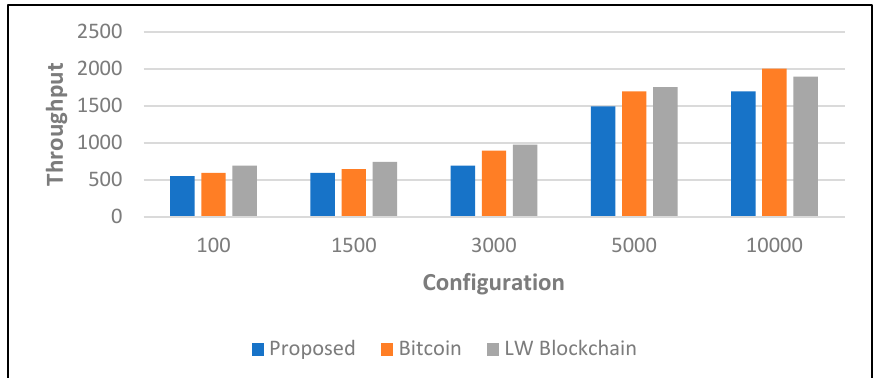
Figure 10. Analysis of transaction throughput.